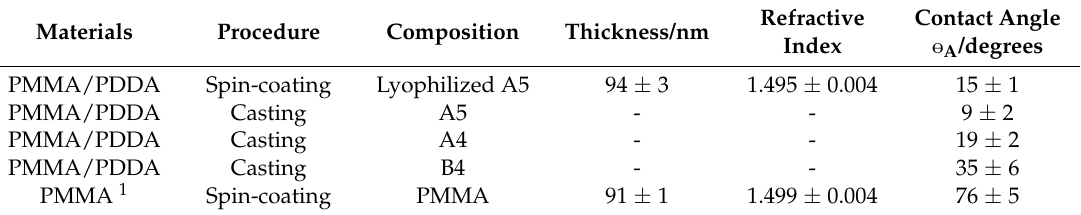
Table 1. Physical properties of PMMA/PDDA coatings on silicon wafers. The procedures for coating were: (1) spin-coating of lyophilized A5 in 1: 1 dichloromethane: ethanol; (2) casting of A5, A4, or B4 NPs dispersions followed by drying under vacuum.